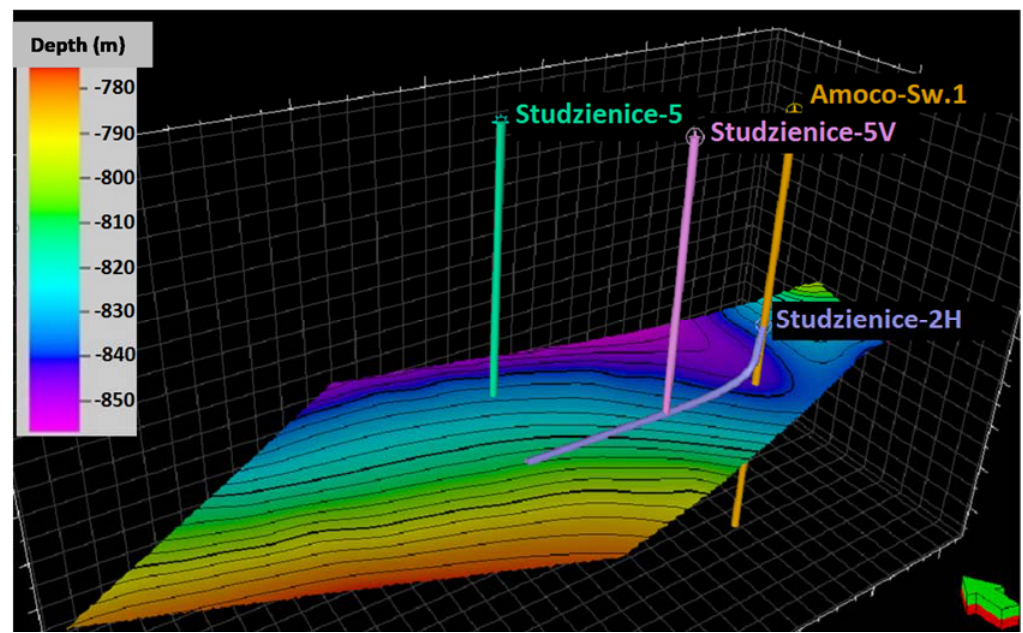
Figure 3. The deposition of seam 337 within the selected tectonic block.